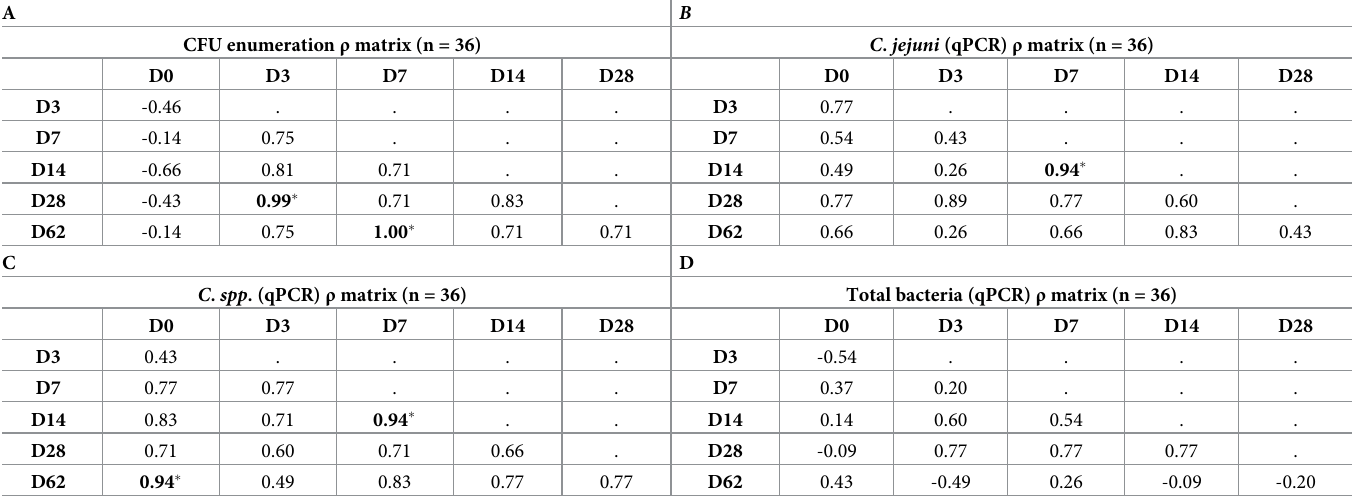
Where ρ = 1 depicts similarities between two ranking orders, ρ = 0 reflects an absence of correlations, and ρ = -1 shows opposite